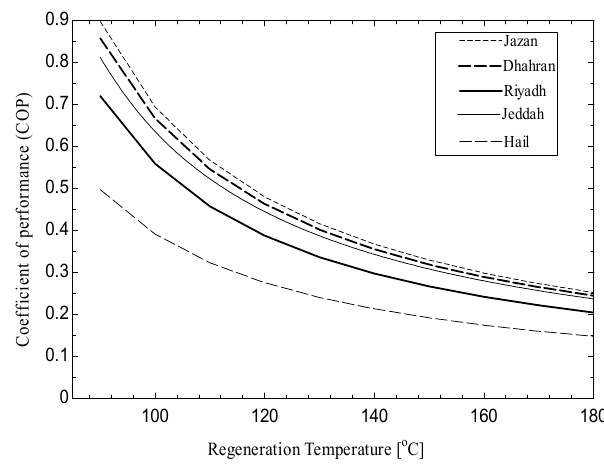
Figure 7. Variation of coefficient of performance with regeneration temperature.